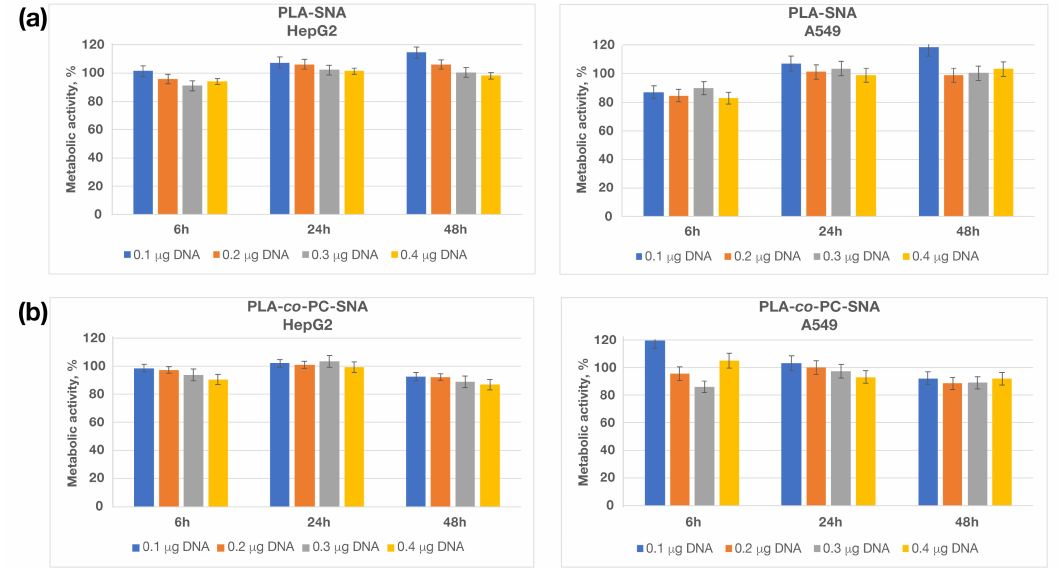
Figure 6. Metabolic activity of HepG2 and A549 cell lines after 6-h incubation with different concen- trations of: ( a ) PLA-SNA; ( b ) PLA- co -PC-SNA. The MTT assay was performed immediately after treatment with SNAs (6 h), after 24 h and after 48 h. Data are presented as percentage of untreated controls and expressed as a mean ± SE, n =